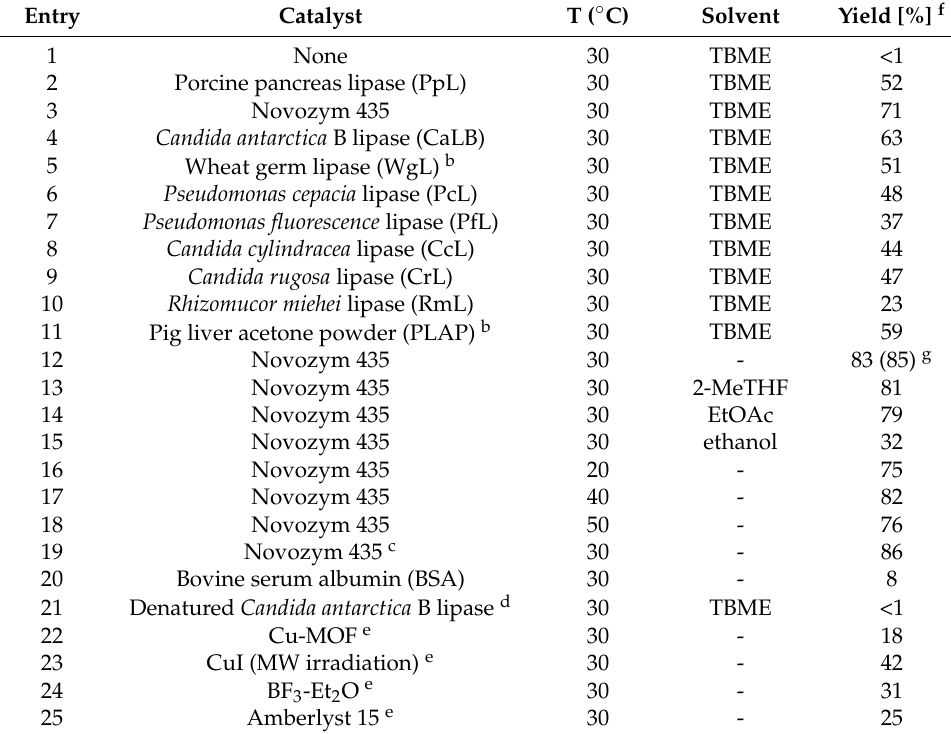
Table 1. The Kabachnik–Fields reaction catalyzed by enzymes. a. Optimization studies.